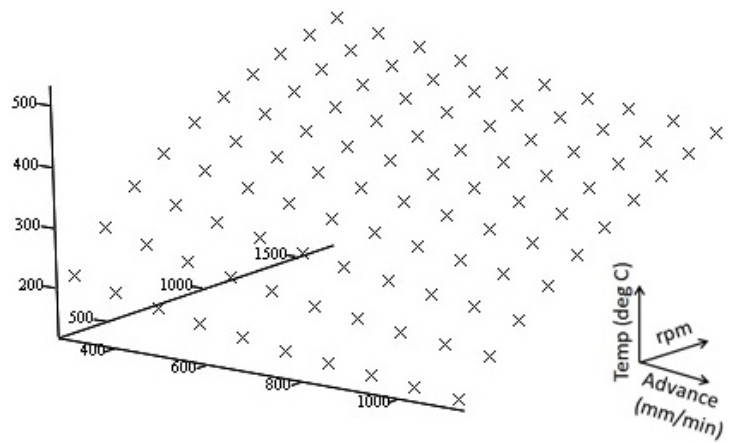
Figure 6. Data points from Monte-Carlo simulation (MCS)